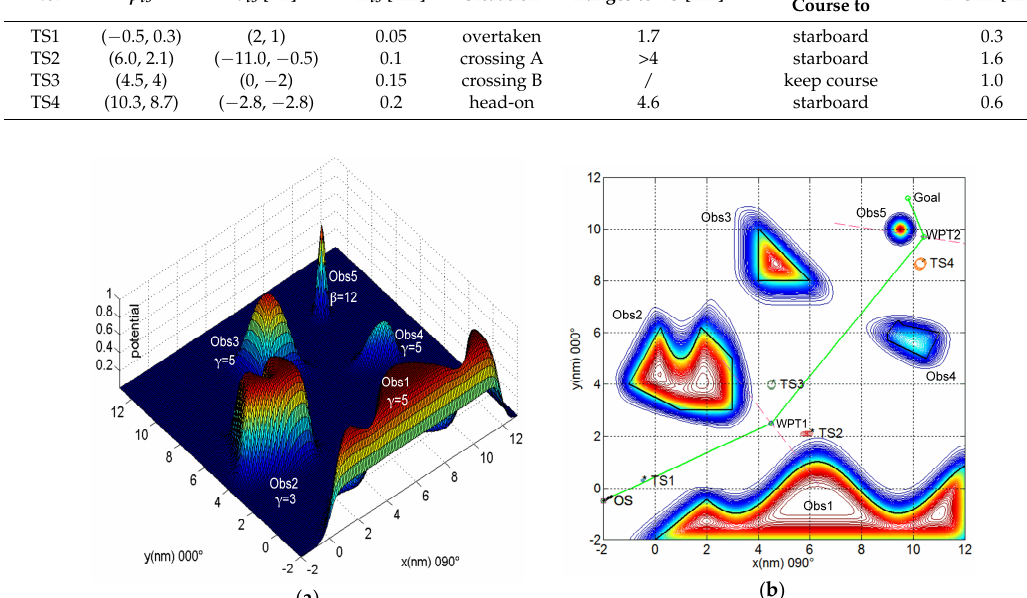
Figure 14. ( a ) Three-dimensional potential field diagram of all static obstacle environments, including the parameter setting of each obstacle; ( b ) there is a low speed ship TS1 1.7 nm ahead of the own ship. The own ship, whose initial course is 060°, is coming up with TS1 from a direction more than 22.5° abaft the TS1’s beam, which is deemed an overtaking situation. The own ship should keep clear of TS1 and take account of the influences of Obs1, Obs2 and TS2 in this narrow channel.